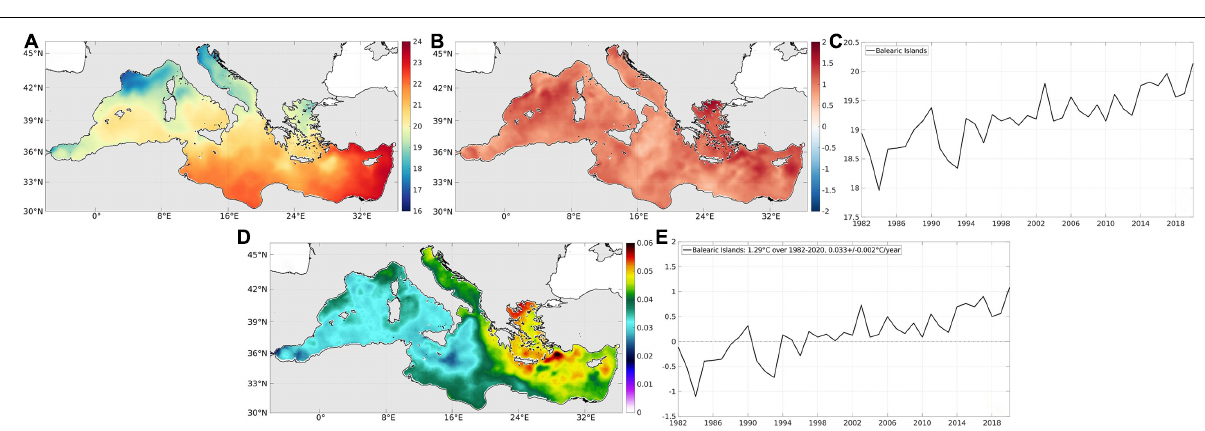
FIGURE 3 | Illustrations for annual SST (in ◦ C): annual mean in 2020 (A–C) and linear trend over 1982–2020 (C,D) : 2D maps of mean SST (A) , mean SSTA (B) , and trend (D) , and time series of SST and SSTA averaged in the Balearic Islands since 1982 (C,E)